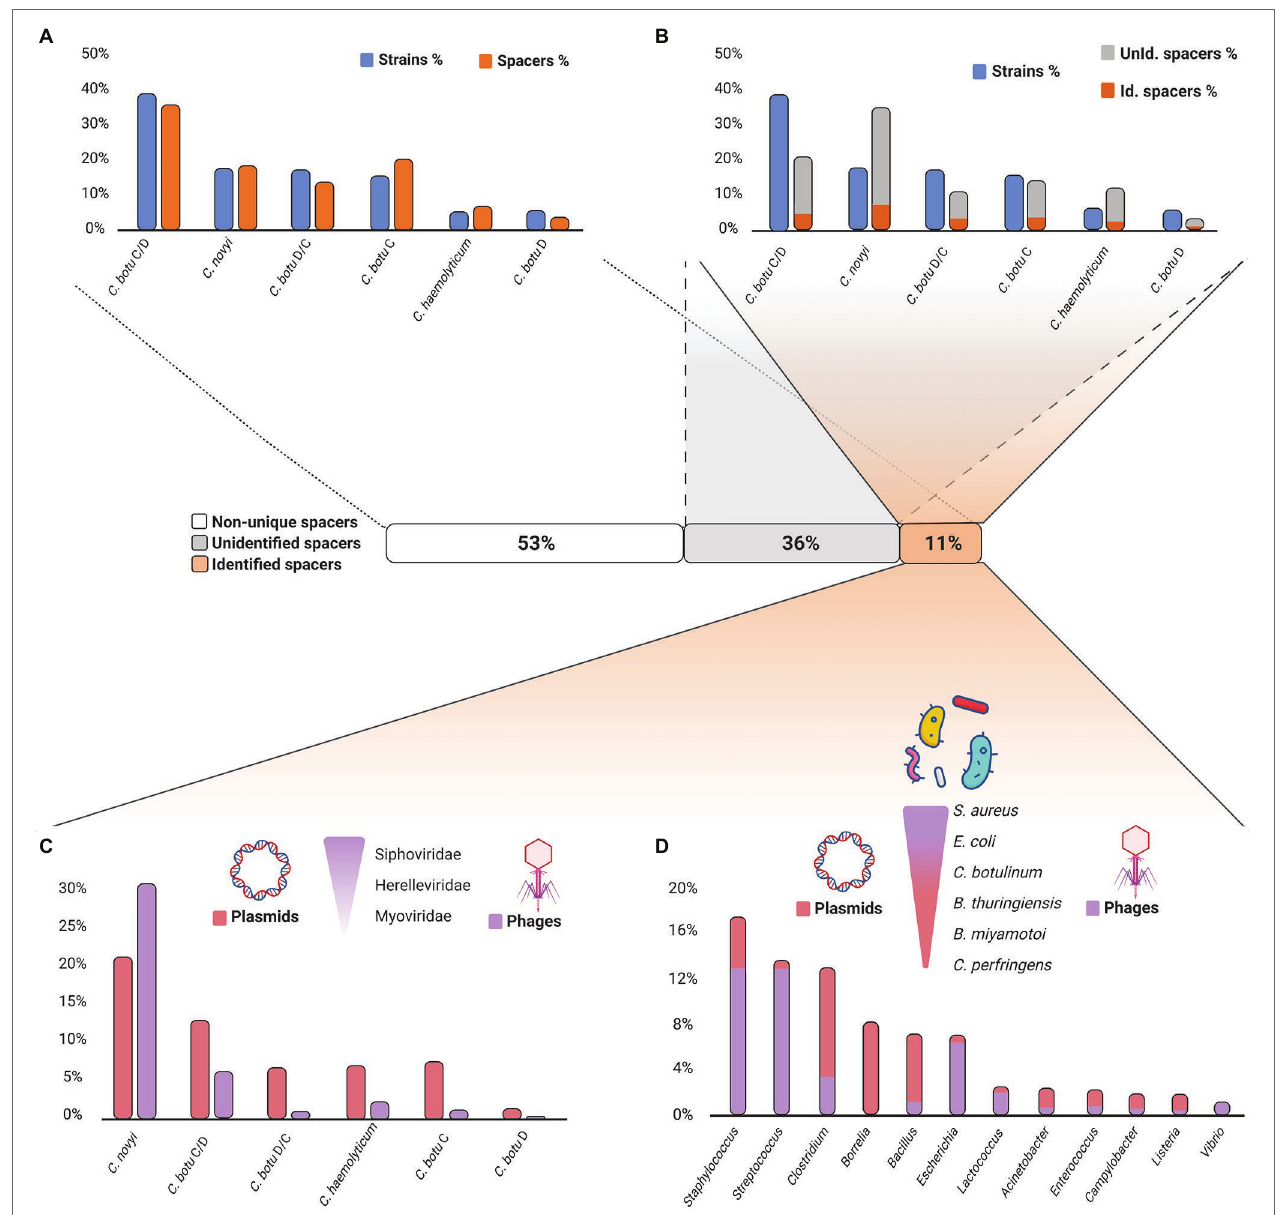
FIGURE 4 | Exploration of Clostridium novyi sensu lato spacer content. Created with BioRender.com. (A) Distribution of spacers among the analyzed Clostridium novyi s.l. strains. Comparison of the distribution of spacers among the analyzed Clostridium novyi sensu lato strains. Overall, each species contributed equally to the total number of spacers. Raw data are available in Supplementary Table S1 . (B) Identified and unidentified unique spacer distribution among the analyzed Clostridium novyi sensu lato strains. Comparison of the distribution of identified and unidentified spacers and their species origin based on unique spacer sequences. Clostridium novyi spacers are the main contributor to the unique spacer content. The distribution of the identified spacers is not proportional to the number of strains in each species. Raw data are available in Supplementary Tables S3 and S4 . (C) Distribution of the MGE origins among Clostridium novyi sensu lato spacers. Plasmids and phages are equal sources of protospacers. Among the phage protospacer origins, Siphoviridae , Myoviridae , and Herelleviridae predominate. Clostridium novyi and Clostridium botulinum BoNT C/D are the main analyzed species carrying the protospacers. Raw data are available in Supplementary Tables S6 and S7 . (D) Targeted MGE host origins among the Clostridium novyi s.l. spacers. Exploration of the hosts of the MGEs identified as targets of the CRISPR spacers found in Clostridium novyi sensu lato . The MGEs originate mainly from Clostridium , Bacillus , Streptococcus , and Borrelia genera. The main species in these genera are C. botulinum ,